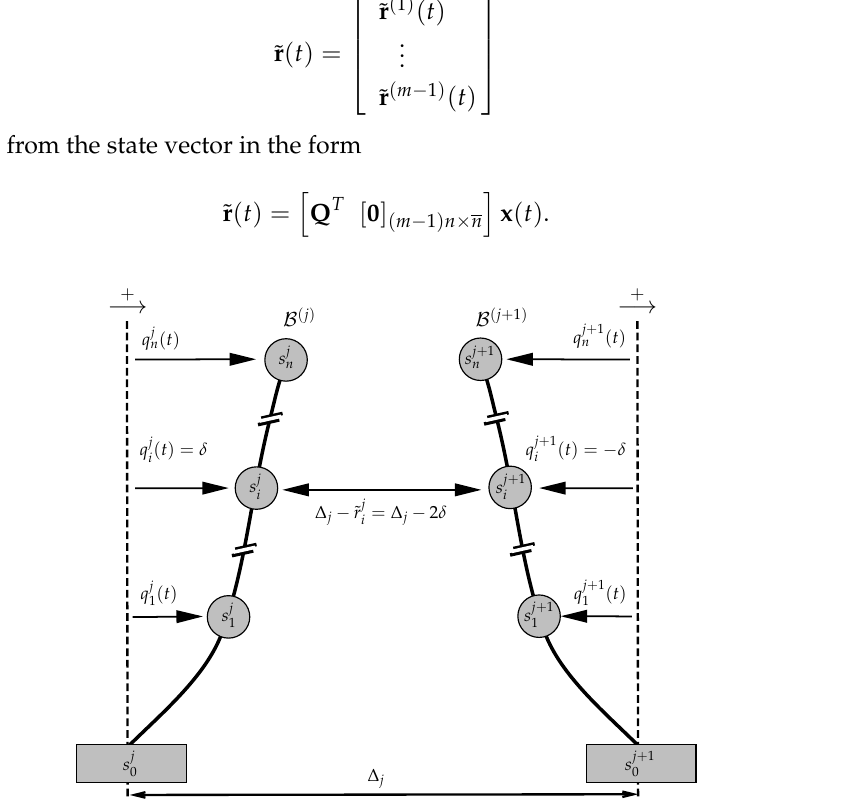
+ 1 and s j corresponding to the interbuilding approaching i i ( j ) and ( j + 1 ) with an interbuilding gap ∆ B B